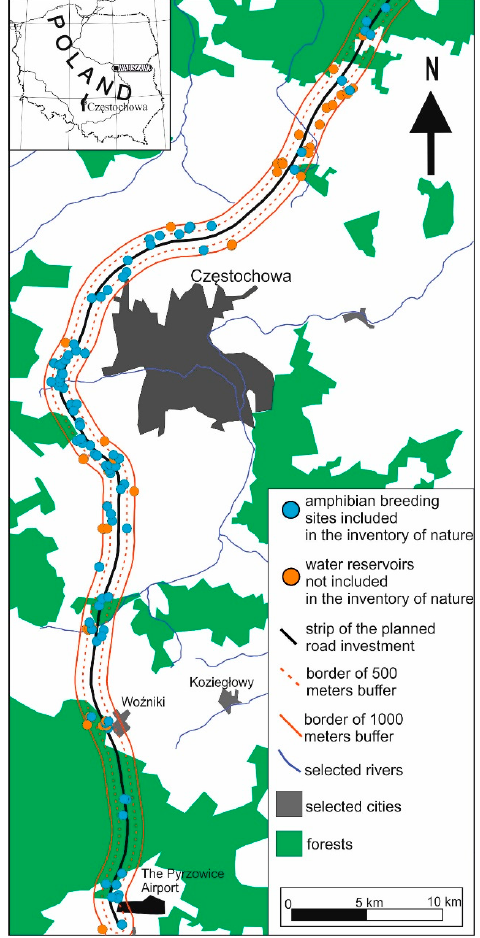
Figure 2. Localization of the section of the A1 motorway under analysis.